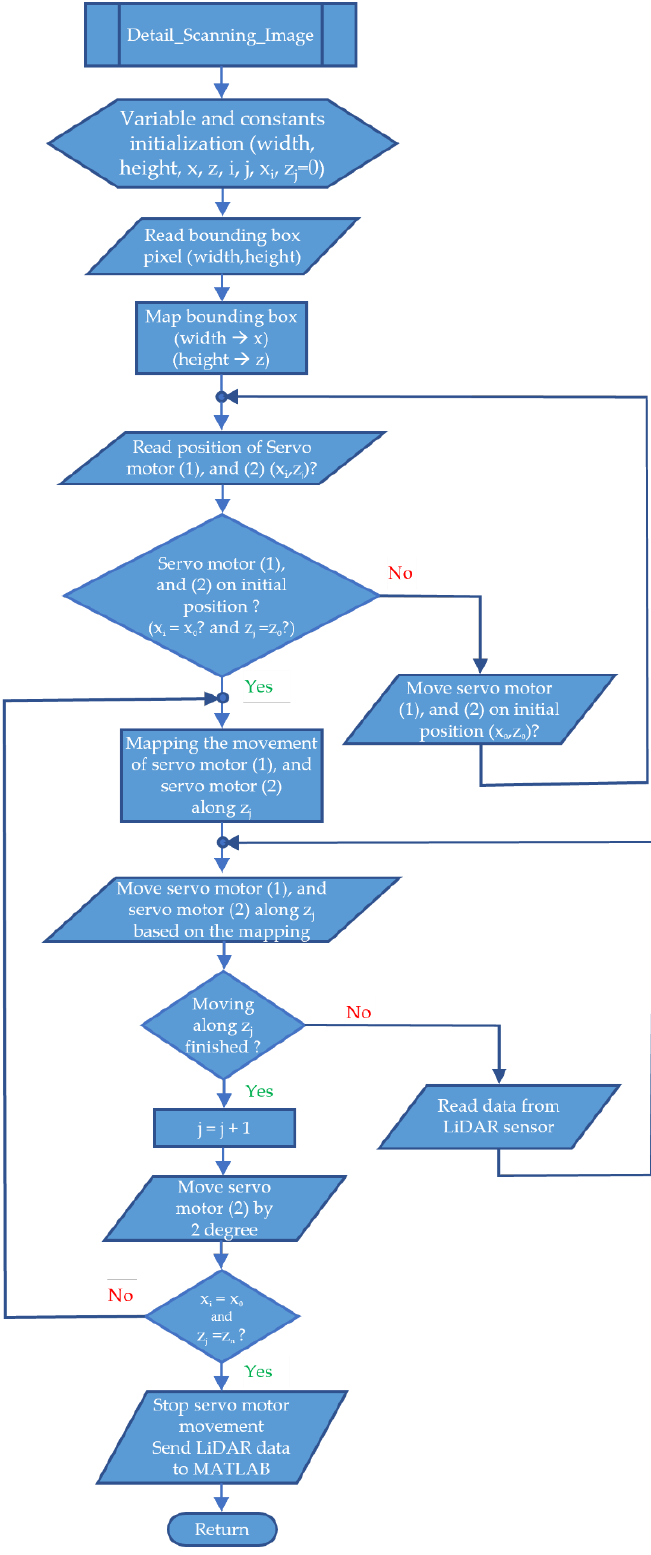
Figure 15. Flowchart of detail scanning image.